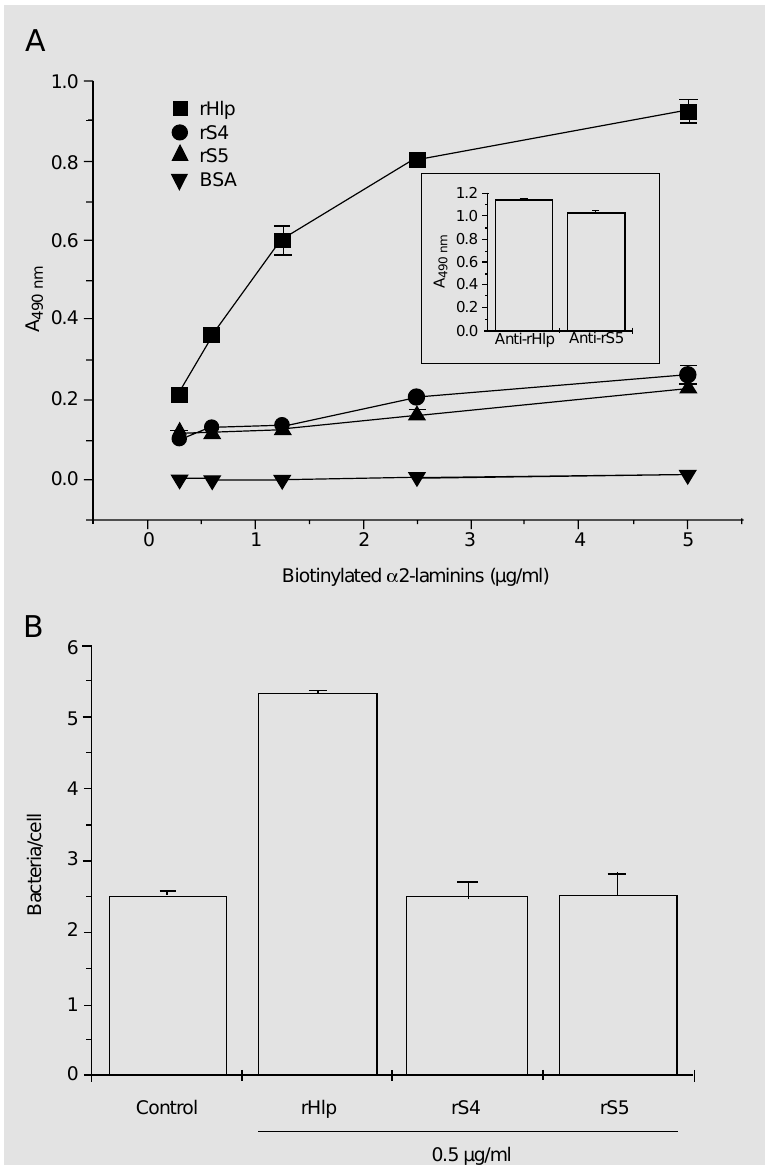
Figure 2 - A , Laminin-binding capacity of M. leprae S4 and S5 analyzed by ELISA. Microtiter wells coated with M . leprae rHlp, rS4, rS5 and BSA were incubated with different concen- trations of biotinylated a 2-laminins. In the inset , microtiter wells coated with M . leprae rHlp and rS5 were incubated with mouse polyclonal antibodies (1:500) anti-rHlp and anti-rS5, respectively. Binding is expressed as absorbance units at 490 nm. Data represent the mean ± SEM of five experiments carried out in triplicate. B , Recombinant Hlp but not S4 and S5 enhanced M. leprae adherence to Schwann cells. Recombinant Hlp, S4 and S5 were purified from a bacterial extract of the recombinant clone using the IMPACT system. ST88- 14 cells were cultivated on 24-well tissue culture plates and incubated with FITC-labeled M. leprae pretreated with 0.5 µg/ml of rHlp, rS4 and rS5. After 1 h of incubation, unbound bacteria were removed by washing and cells were stained with ethidium bromide and analyzed under a fluorescence microscope. Results are reported as the average number of bacteria per cell. Data represent the mean ± SD of a typical experiment carried out in duplicate. Five experiments were performed with similar